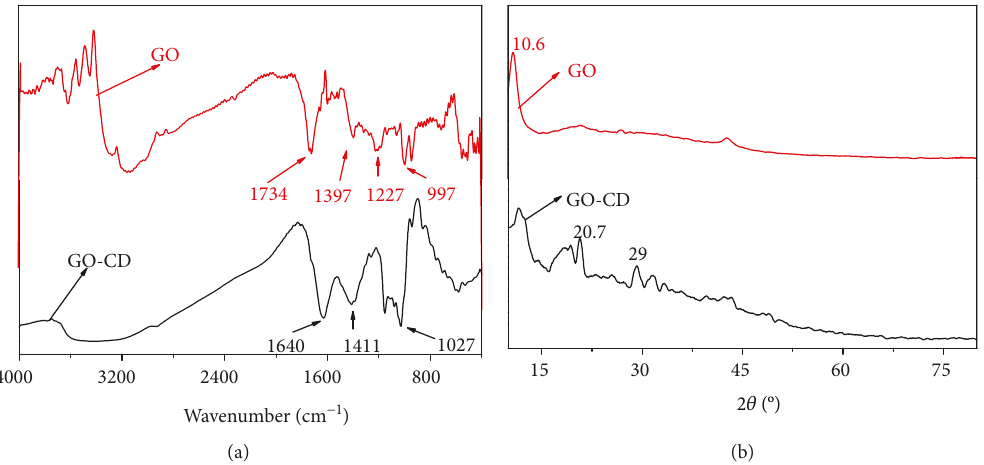
Figure 4: IR spectra (a) and XRD spectra (b) of GO and GO-CD.